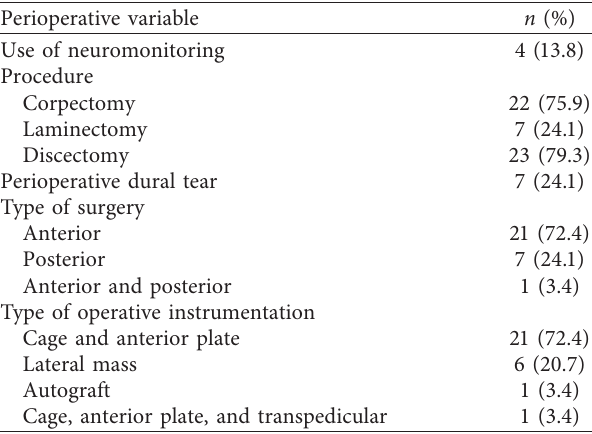
Table 2: An overview of procedural and perioperative parameters in our population.